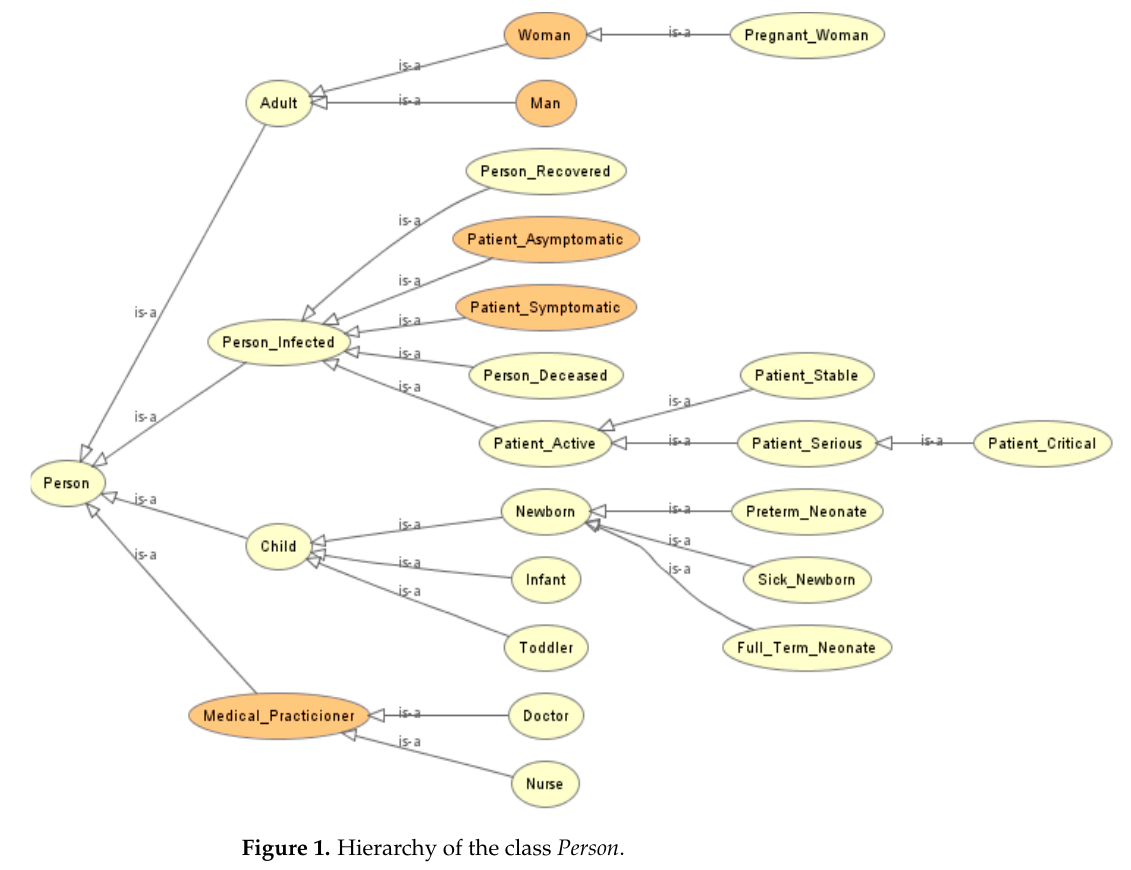
Figure 1. Hierarchy of the class Person .